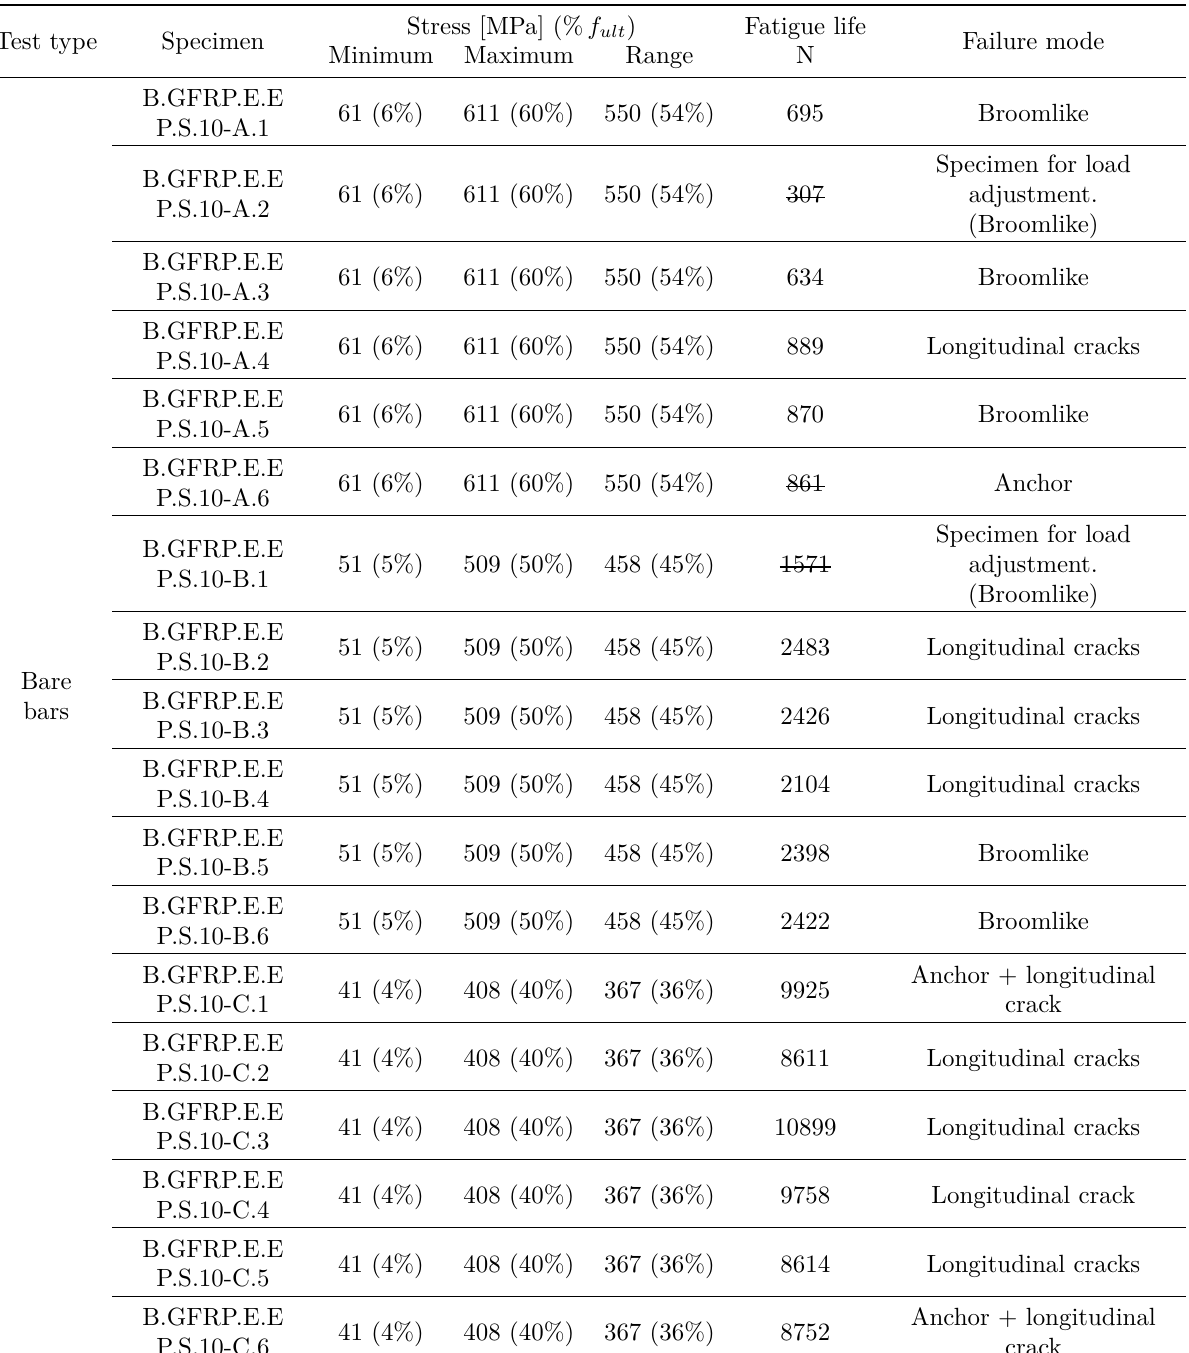
Table 3. Tested specimens - fatigue